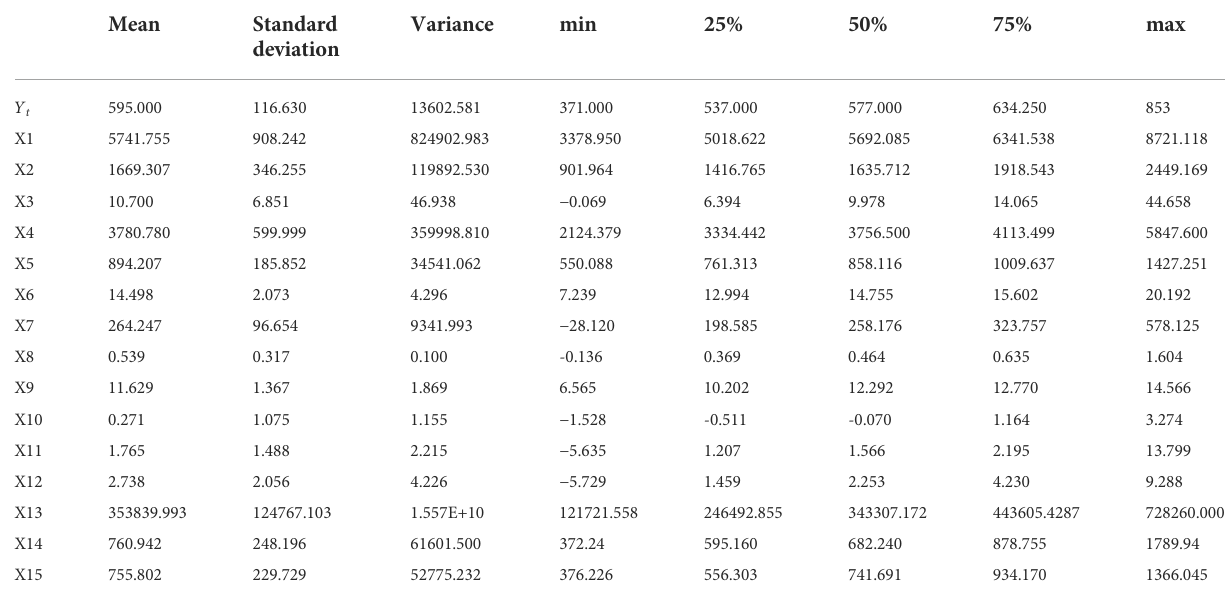
TABLE 2 Descriptive statistics of coal price data.